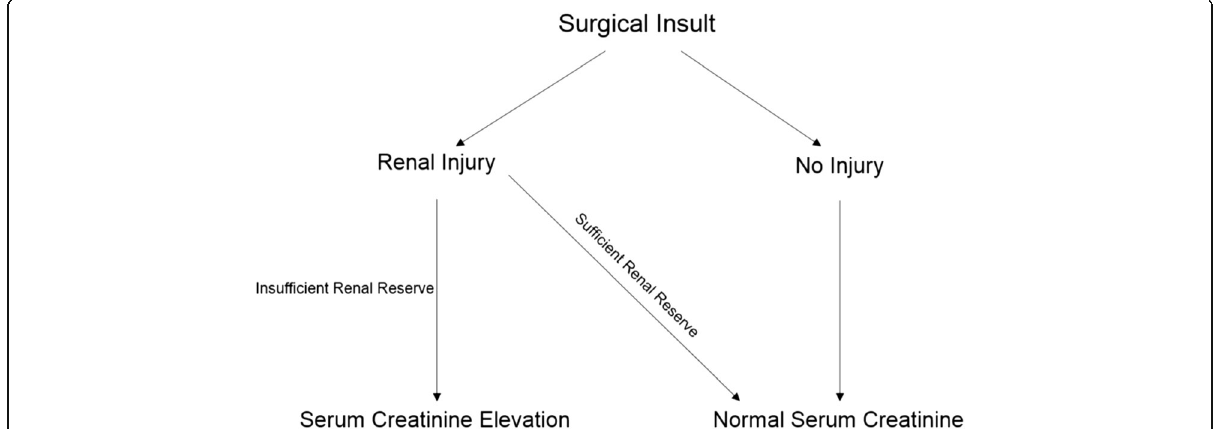
Fig. 1 Directed acyclic graph displaying the hypothesized mechanism which would result in statistically heterogeneous subpopulations with respect to serum creatinine